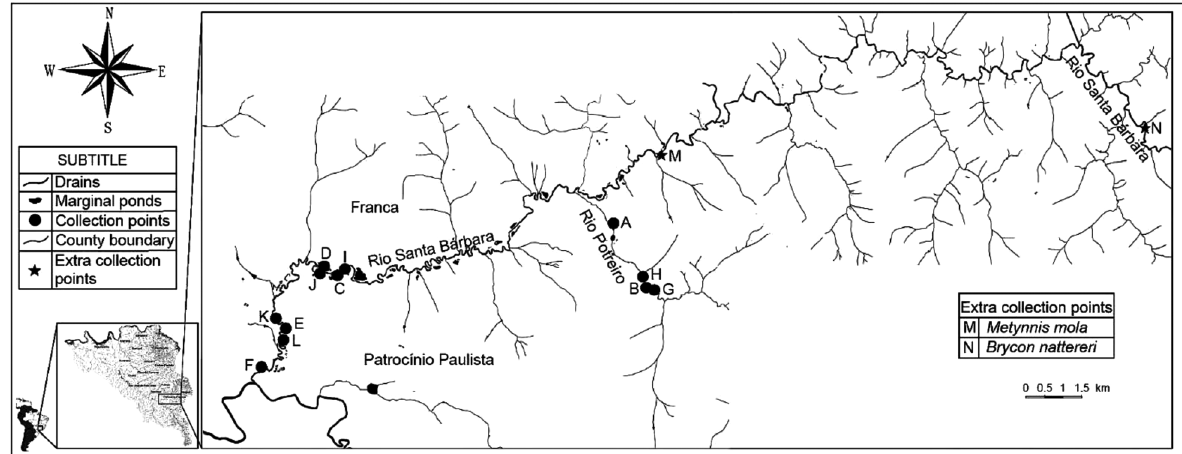
Figure 1. Location of Rio Santa Bárbara, Rio Potreiro, marginal lakes and sampled sites at each river. A, B, G and H at Rio Potreiro; C, D, I and J upper portion at Rio Santa Bárbara; E, F, K and L lower portion at Rio Santa Bárbara; M and N areas not initially selected.